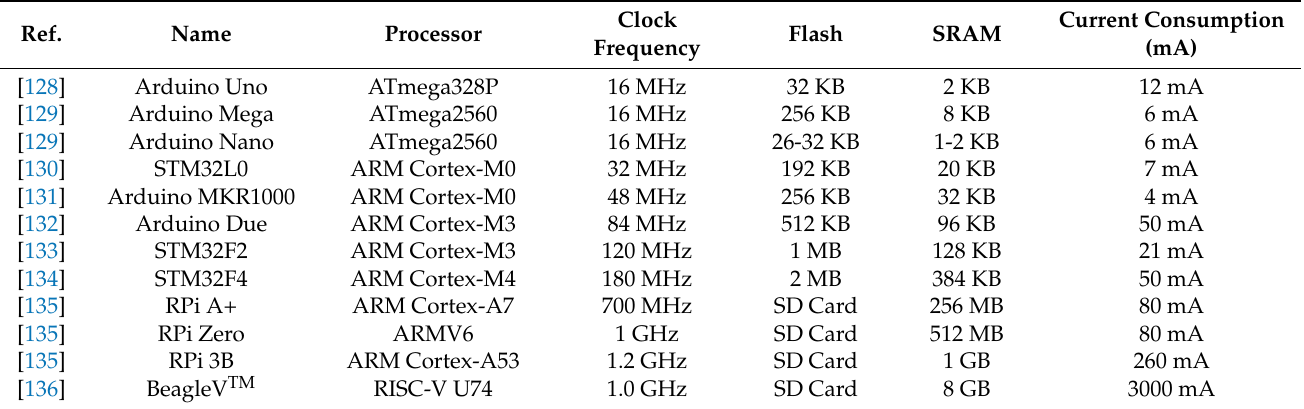
Table 12. Microcontroller units